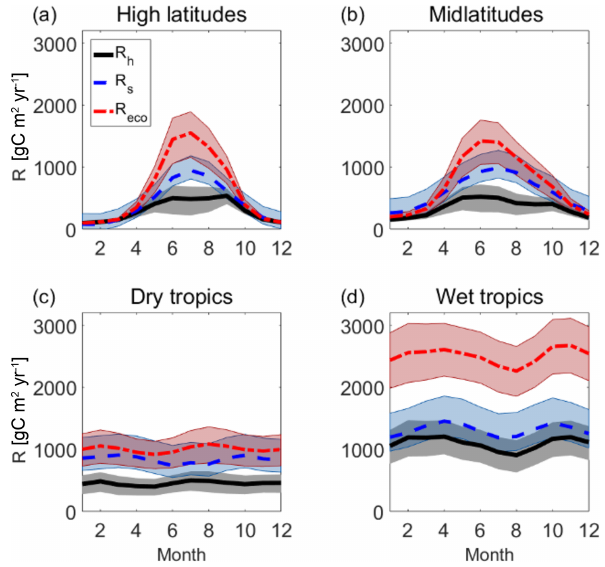
Figure 9. Comparison between the regionally and temporally av- eraged seasonal cycle of different respiration components: top- down R h (black solid line and area), bottom-up R s (dashed blue line and blue area), and top-down R eco (dashed–dotted red line and area). Shaded areas represent the average 25th–75th uncer- tainty bars at each latitude. (a) High latitudes (latitude > 55 ◦ N/S) (b) midlatitudes (30 ◦ N/S < latitude < 55 ◦ N/S), (c) dry tropics (lat- itude < 30 ◦ N/S and mean annual precipitation < 1500mmyr − 1 ), and (d) wet tropics (latitude < 30 ◦ N/S and mean annual precipita- tion > 1500mmyr − 1